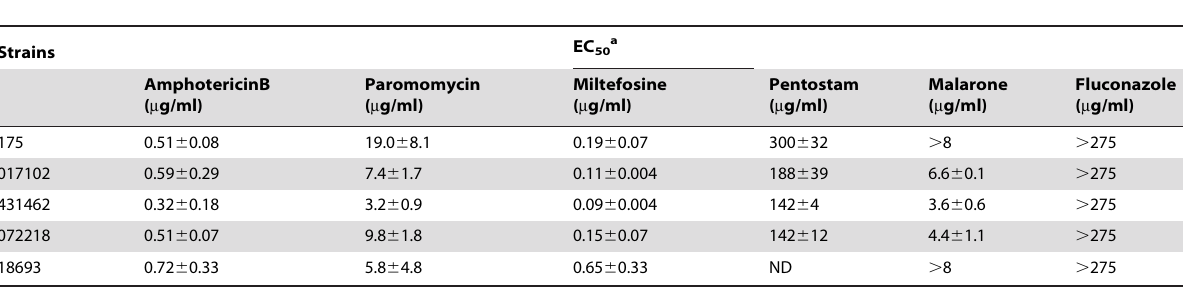
to L. tropica 482 and 072218 that were absent from L. tropica MHOM/SU/74/K27 (Table 2), and the PGD , G6PDH , and SAD genes, which were not polymorphic in L. tropica MHOM/SU/74/ K27 (Table 2). In contrast to the PTR1 locus, however, the polymorphisms observed at the NH1 , DHFR-TS , SAD , PGD , G6PDH , ASAT , and GPI loci were non-conservative for at least one position, with some genes having several non-conservative heterozygous sites (Table 1). These polymorphisms were not observed in other species outside L. tropica (Table 2). To rule out polymerase errors, the sequencing of at least three independent PCR products was done for each particular nucleotide position, as it would be quite rare that the presence of the same SNPs in different PCR reaction comes from polymerase errors. Moreover, for some genes (for example PTR1), PCR products were TA cloned and independent clones were sequenced for the confirma- tion of the SNPs using primers within the pGEM-T easy vector, hence ruling out the possibility of polymerase errors. Drug susceptibility profiles of L. tropica clinical isolates Three of the four Canadian soldiers were initially treated with oral fluconazole without any clinical improvements. To establish Table 3. Susceptibility of L. tropica clinical isolates to antileishmanial drugs.